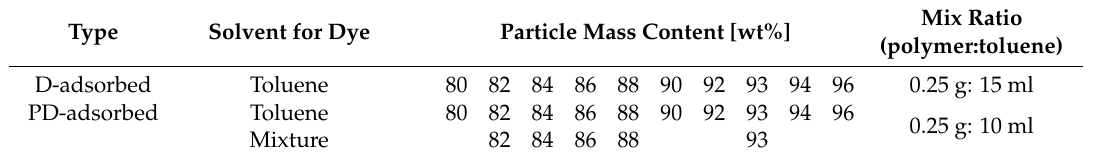
Table 1. Preparation conditions of PC-PSPs.